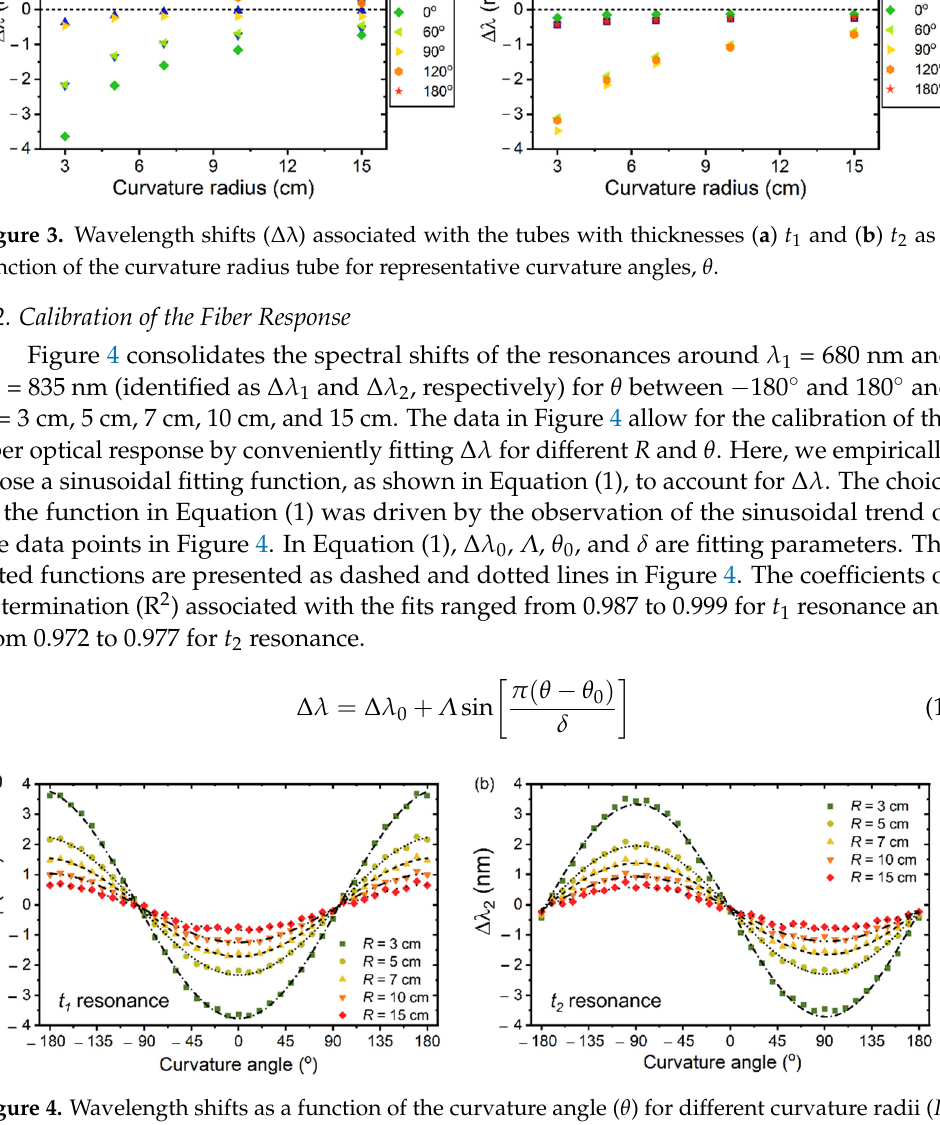
Figure 5. Parameters Δ λ 0 , θ 0 , δ , and Λ as a function of the curvature radius ( R ), corresponding to the resonances associated to the tubes with thicknesses ( a ) t 1 and ( b ) t 2 . Table 1. Fitting functions used to adjust Δ λ 0 , θ 0 , δ , and Λ trends as a function of R ( a , b , c , and d are representative fitting constants). Parameter